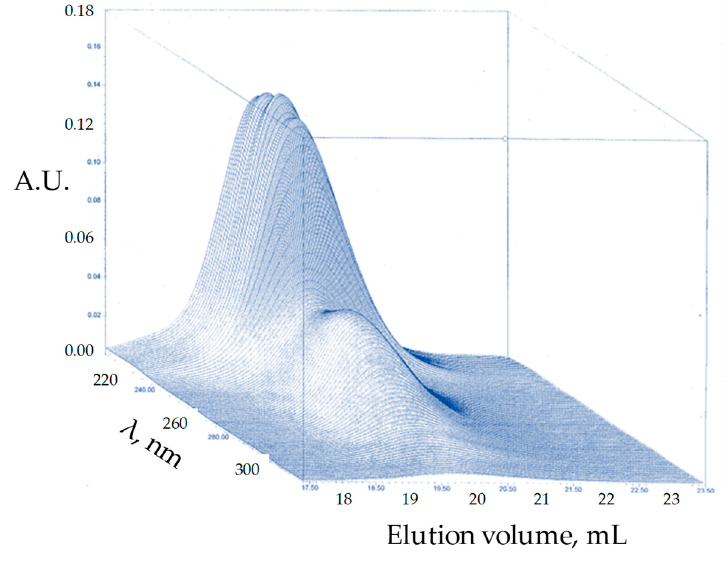
Figure 4. SEC eluogram of a copolymer obtained after simultaneous addition of comonomers (STEM 1, Table 1 and Figure 1a,b). UV PDA trace.